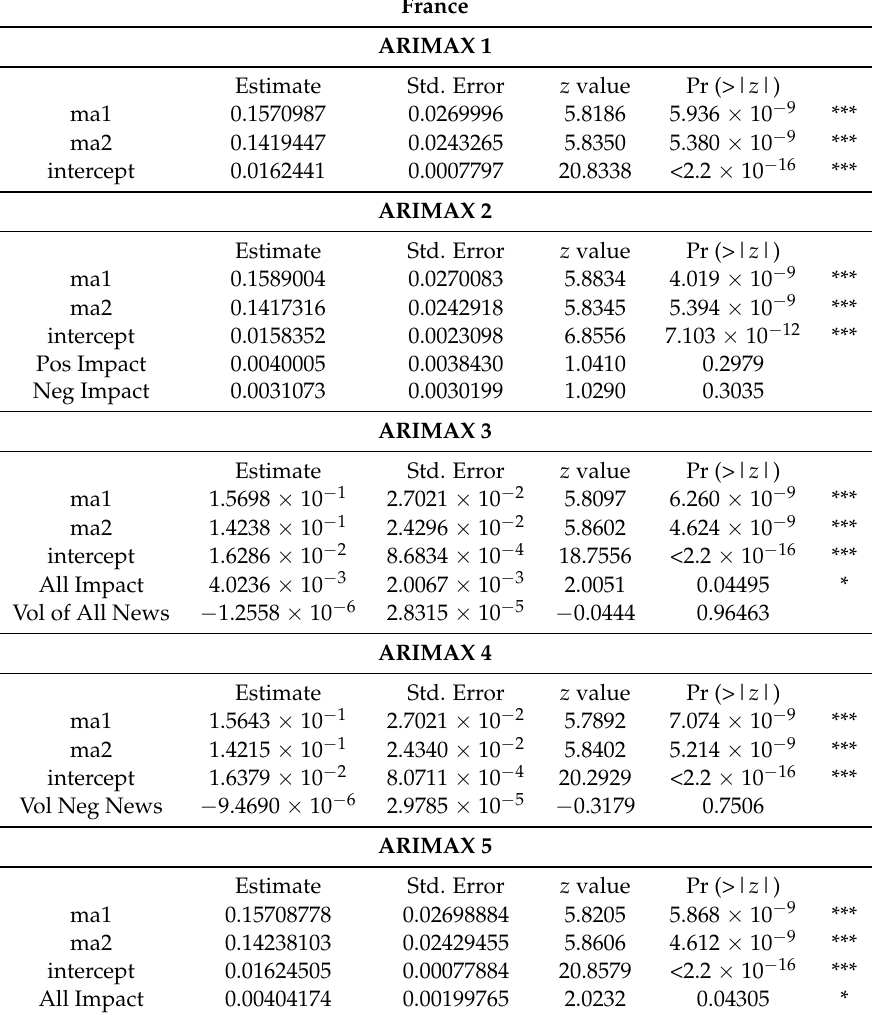
Table 15. z -test of coefficients for ARIMAX models in France for first difference of mean country spread.